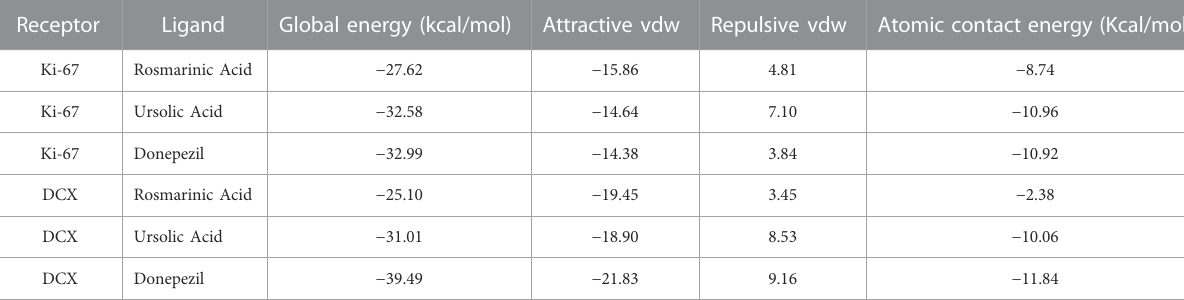
TABLE 2 Protein docking scores re fi ned by